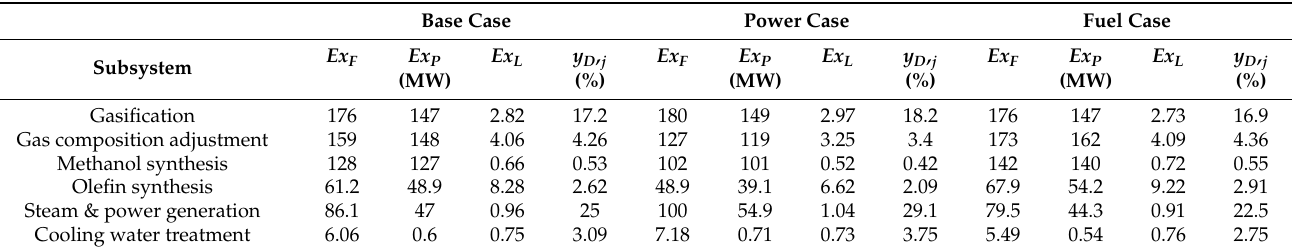
Table 5. Exergy balance at the subsystem